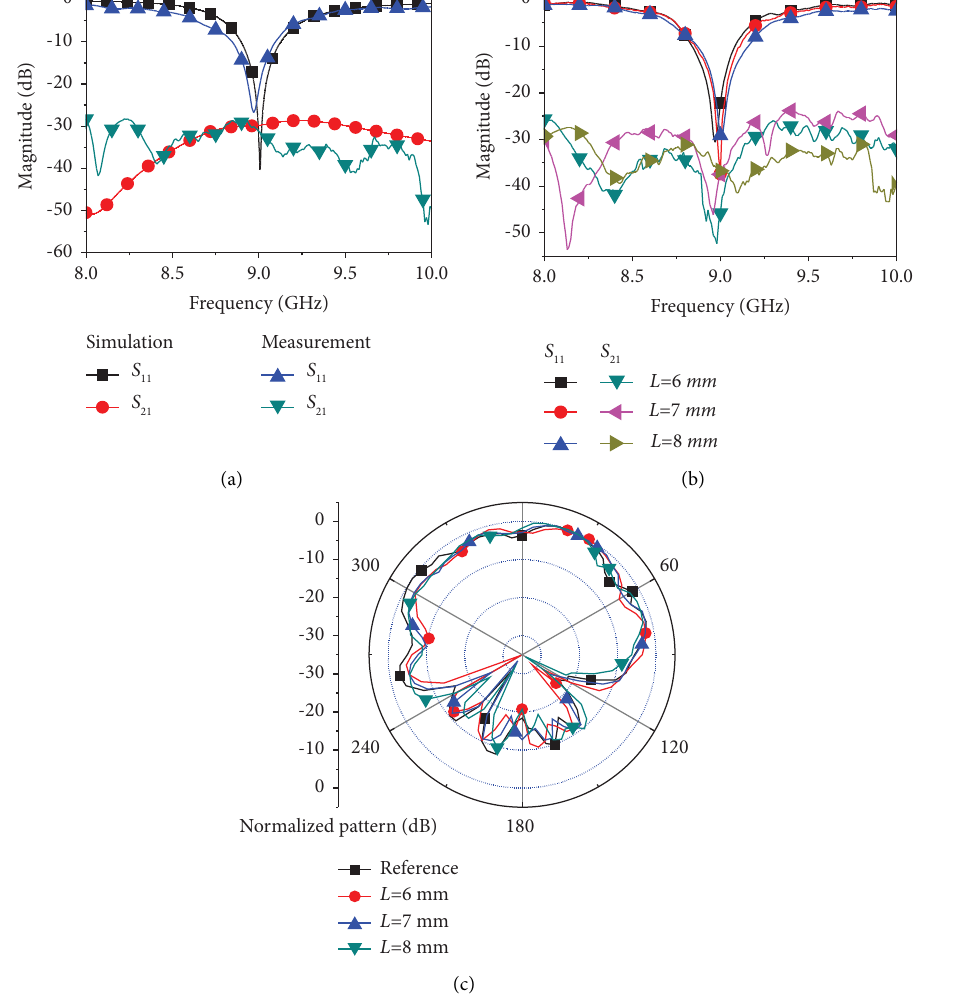
Figure 11: Measurement results of the proposed arrays. (a) S parameters comparison results of the array design by EM simulation. (b) S parameters comparison measurement results of predicted arrays design by FCNN. (c) Normalized radiation pattern comparison results of the reference array and predicted